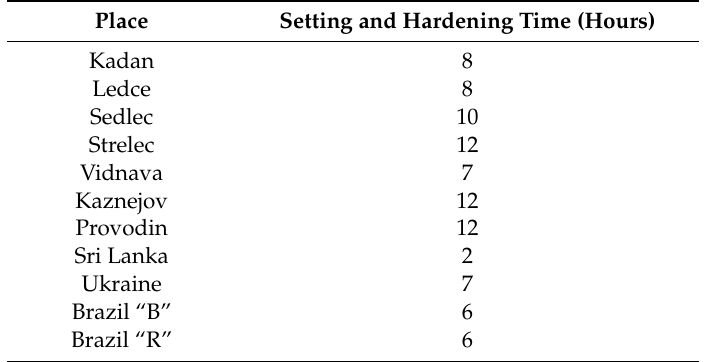
Table 1. The Setting and Hardening Time of Kaolin and Kaolinitic Clay Used.